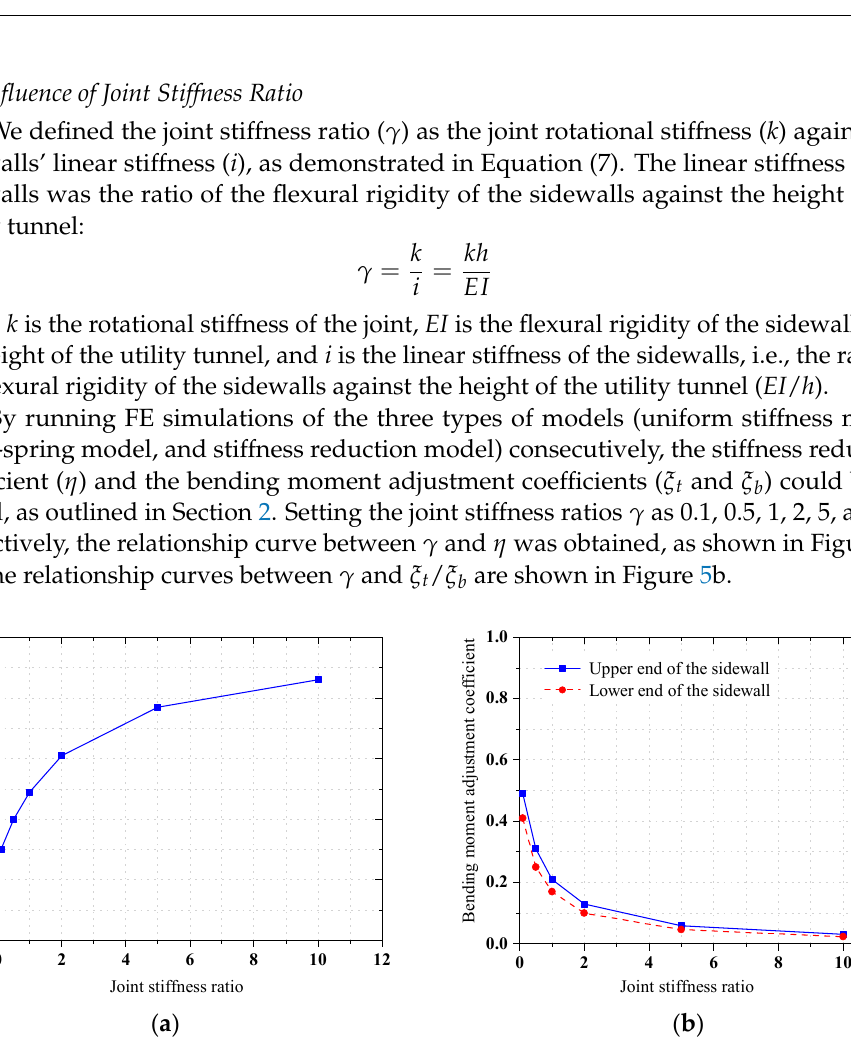
Figure 6. Influence of aspect ratio of width to height: ( a ) stiffness reduction coefficient and ( b ) bend- ing moment adjustment coefficient.